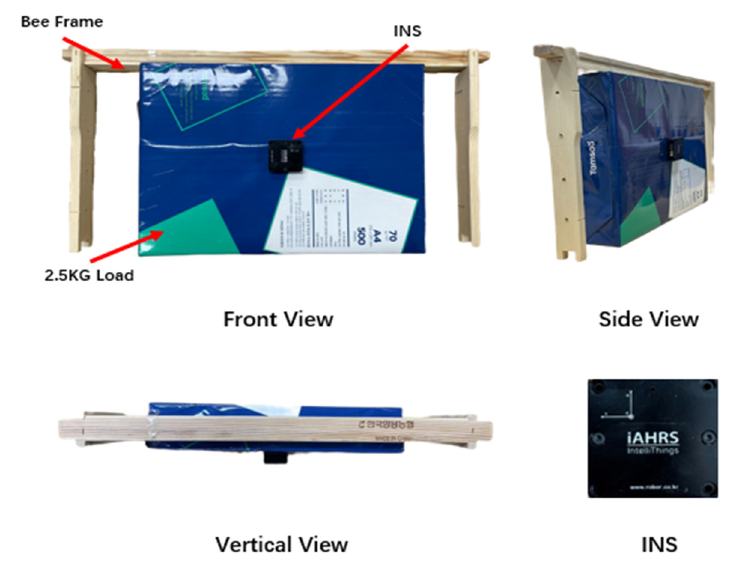
Figure 11. Bee frame modified with INS to simulate a full load of honey.